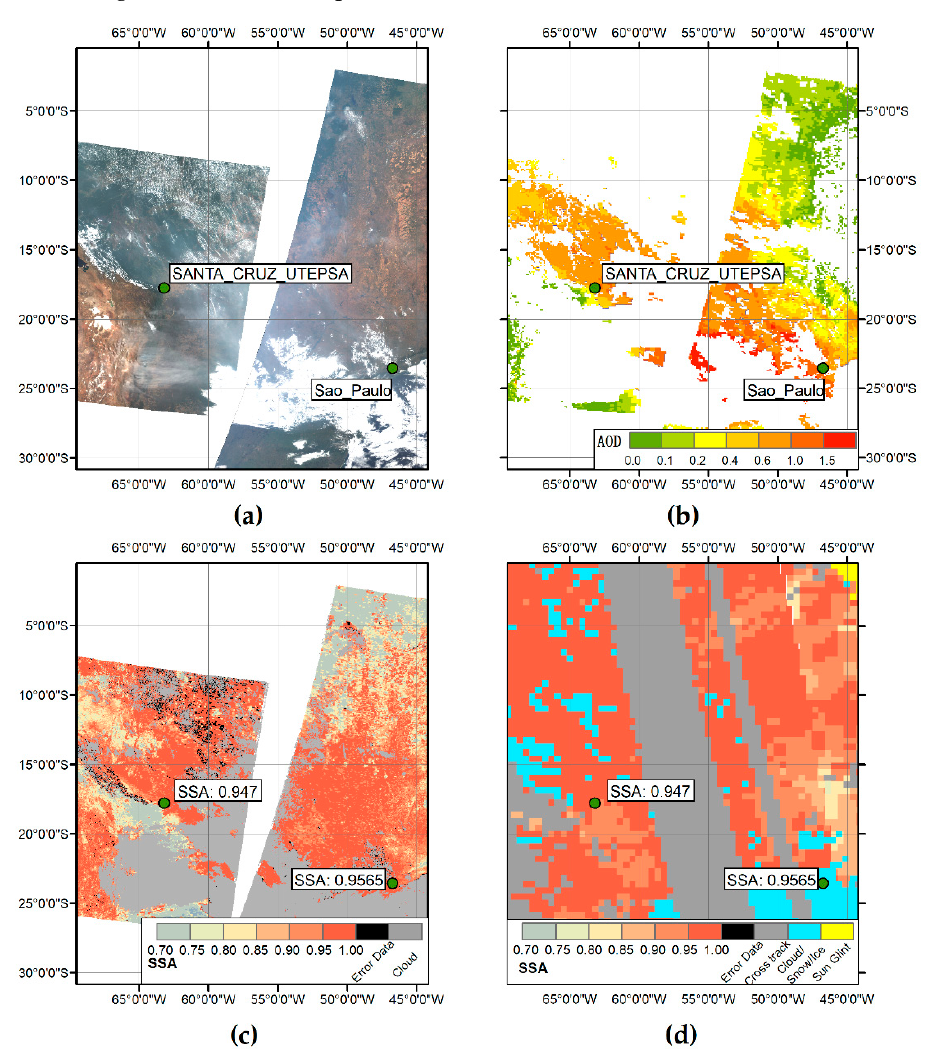
Figure 10. ( a ) True color composite map from MODIS (data came from Terra in South America on 19 September 2019), ( b ) AOD map of MOD04, ( c ) SSA retrieval value of our method, ( d ) SSA retrieval value of OMAERUV. The locations and inversion SSA values of SANTA_CRUZ_UTEPSA and Sao Paulo sites are marked in figures.